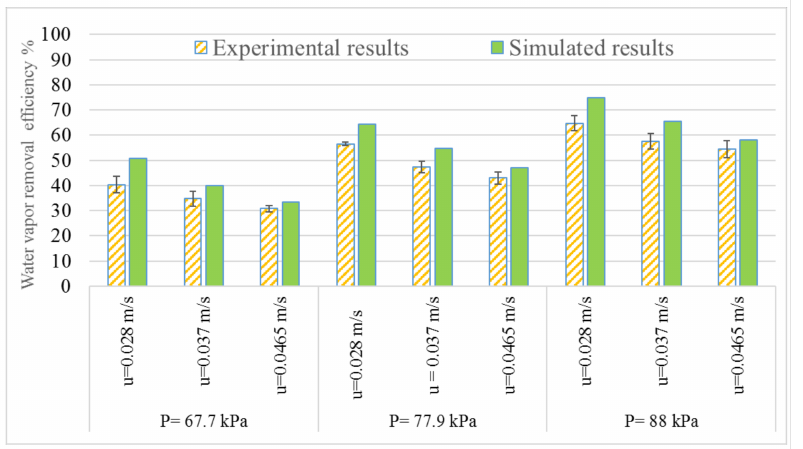
Figure 6. The concentration of water vapor of dehumidified air at outlet of PDMS